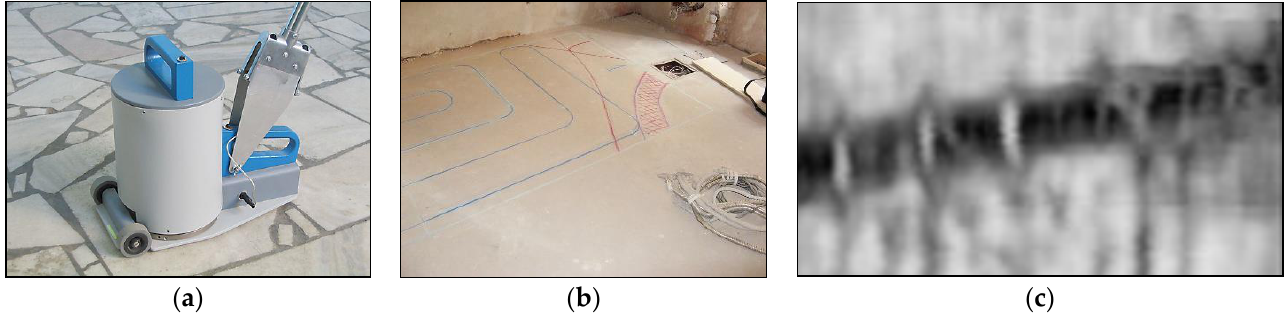
Figure 27. ( a ) HSR antenna, ( b ) pipes and cables marked on the floor, and ( c ) pipes (light) draping over cable (dark). As the survey progressed, the operator analyzed the image and drew the results in chalk on the floor, blue for heating tubes and red for electrical cables. The composite MW image of the total scanned area is presented in Figure 28a and the interpreted layout in Figure 28b.